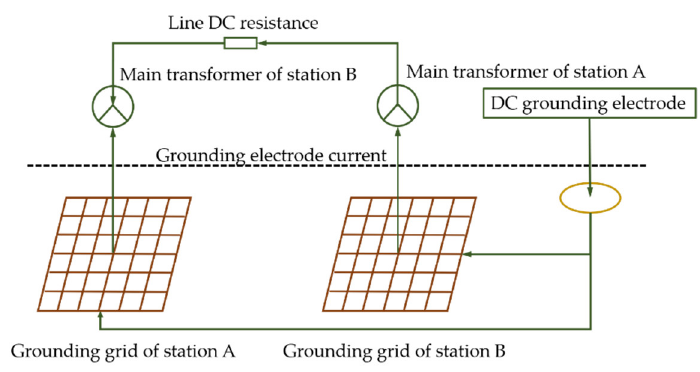
Figure 2. Distribution principle of DC magnetic bias current under unipolar ground mode operation.